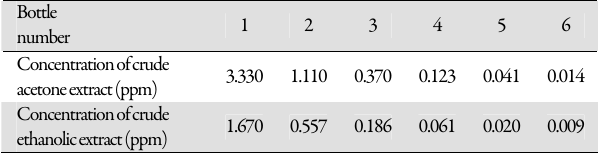
Table 1. The concentrations of crude acetone and ethanolic extracts